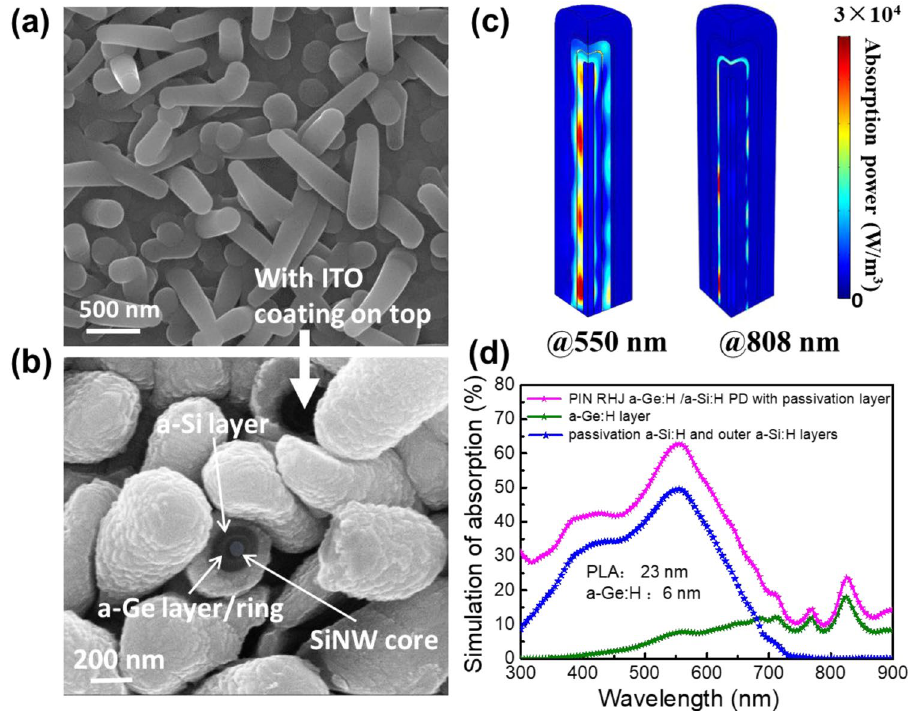
Figure 2. ( a , b ) Illustration of the SEM images of the PIN RHJ PAL/a-Ge:H/a-Si:H PD, before and after ITO coating, the inset shows the RHJ unit in full details, the corresponding finite element simulated absorption profile within the unit at 550 nm, 808 nm simulated by COMSOL shows in ( c ), the simulation of absorption extracted from RHJ unit show in ( d